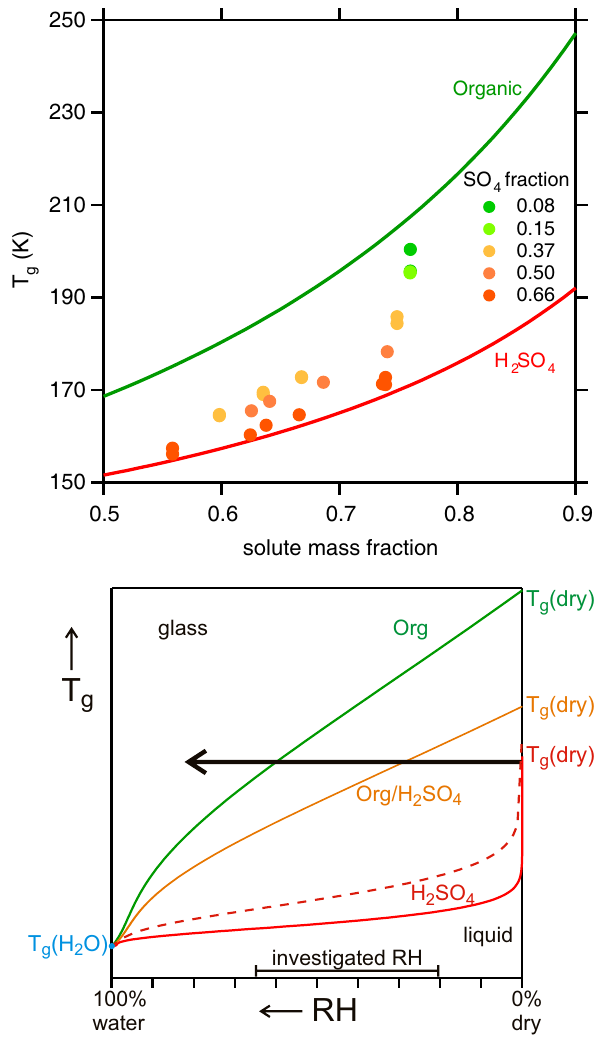
Fig. 6. Top: addition of H 2 SO 4 to an organic (here: glucose) leads to a strong reduction in T g at the same water content (Pedern- era, 2008). The effect is even more pronounced when plotted as a function of relative humidity (because of the different hygroscop- icities of organics and sulfate). The bottom panel is a schematic picture of T g versus equilibrium relative humidity for various or- ganic/sulphuric acid